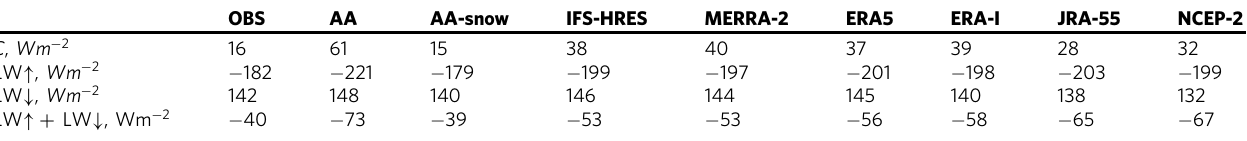
Table 2 Surface energy budget – Clear sky event